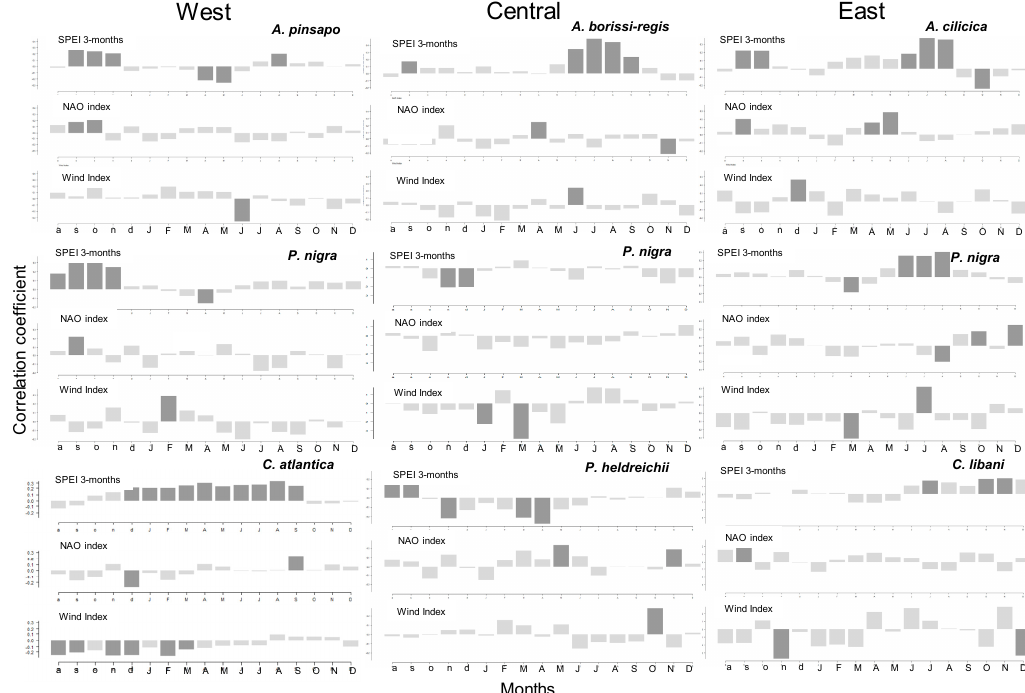
Months Figure 6. Bootstrapped tree growth–climate associations for the studied sites assessed by relating ring-width indices (TRWi) to monthly SPEI3, NAO, and WI indices for the period 1946–2001. The temporal window of analyses includes the time from the previous August (previous-year months are abbreviated in lowercase letters) up to the current December (current-year months are abbreviated in uppercase letters). Significance levels are shown in grey color ( p < 0.01). Sites’ codes are as in Table 1.